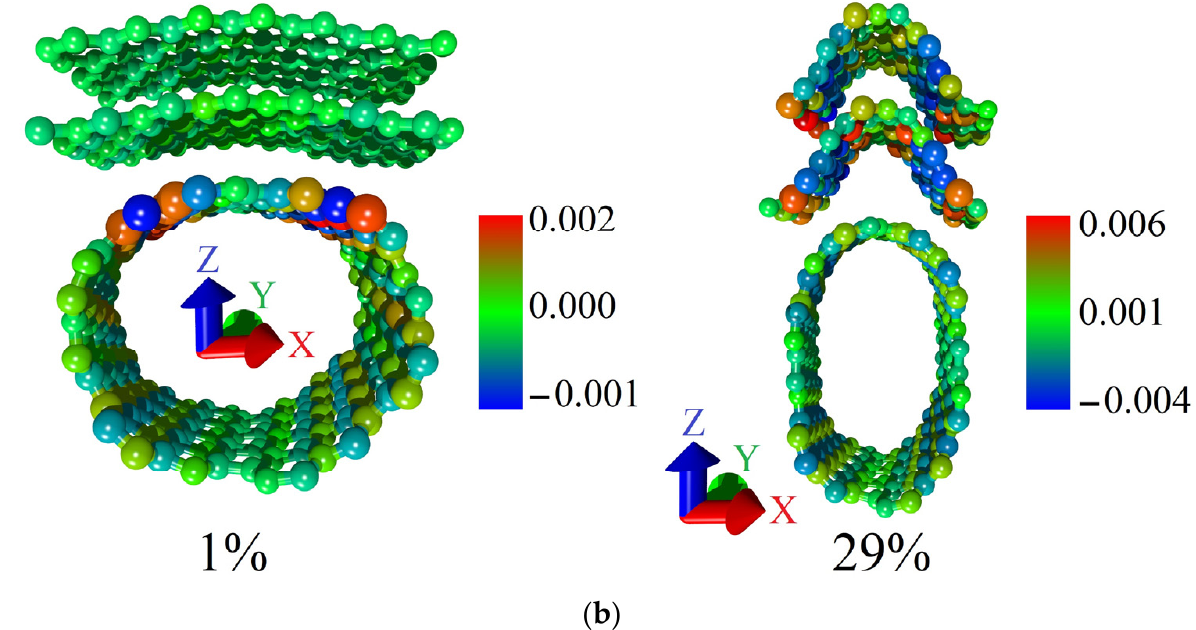
Figure 10. Distribution of the electron charge density over the supercell atoms of bilayer graphene- SWCNT (12,6) hybrid films with island topology for the cases of minimum and maximum allowable axial compression: ( a ) model V1; ( b ) model V2.